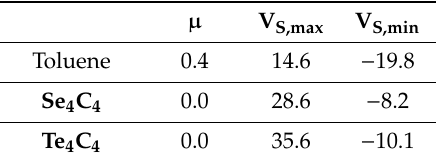
Table 1. The Dipole moment ( µ ) and the maximaum and minimum values of the electrostatic potential of the molecular surfaces (V S,max and V S,min , respectively) computed at the HF / def2-TZVP level. Energies are in kcal mol − 1 and µ in